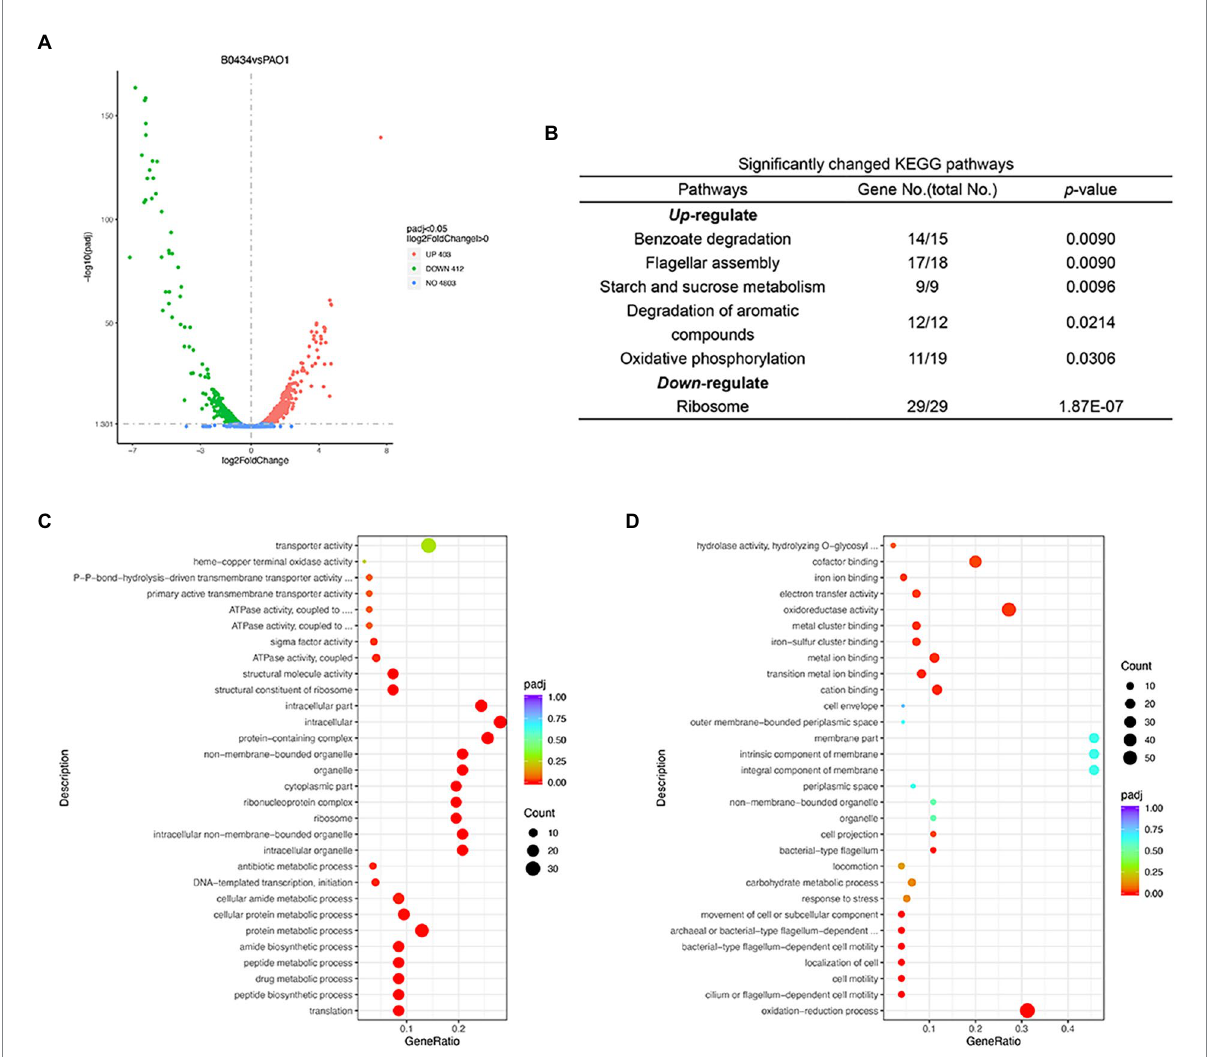
FIGURE 5 Effects of Ribavirin on the transcriptome of Pseudomonas aeruginosa PAO1. (A) Number of significantly differentially expressed genes of P. aeruginosa PAO1 influenced by 200 μ M of Ribavirin. (B) Significantly changed KEGG terms influenced by 200 μ M of Ribavirin. Significantly (C) downregulated and (D) upregulated GO terms caused by 200 μ M of